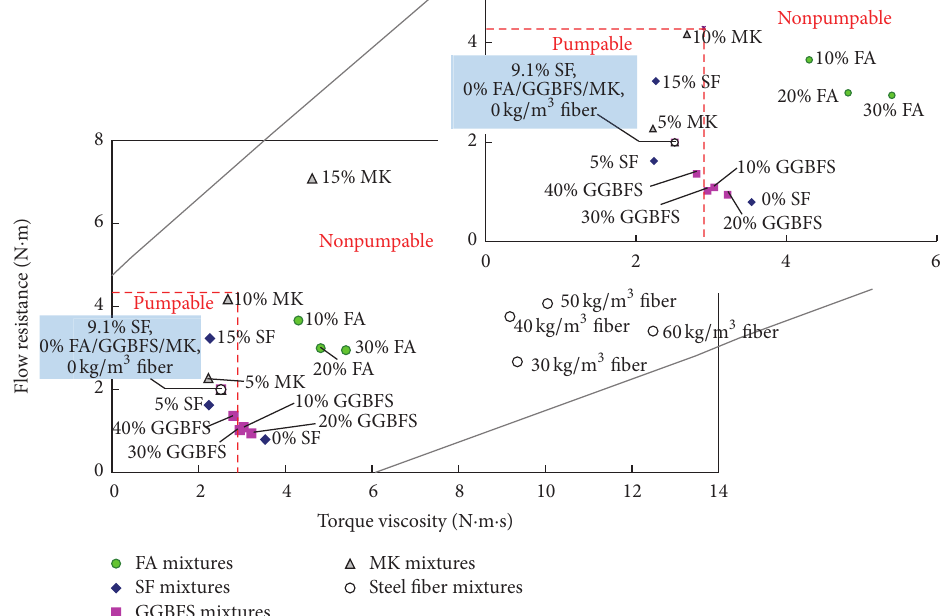
Figure 11: Pumpability predictions for various WMS mixtures.